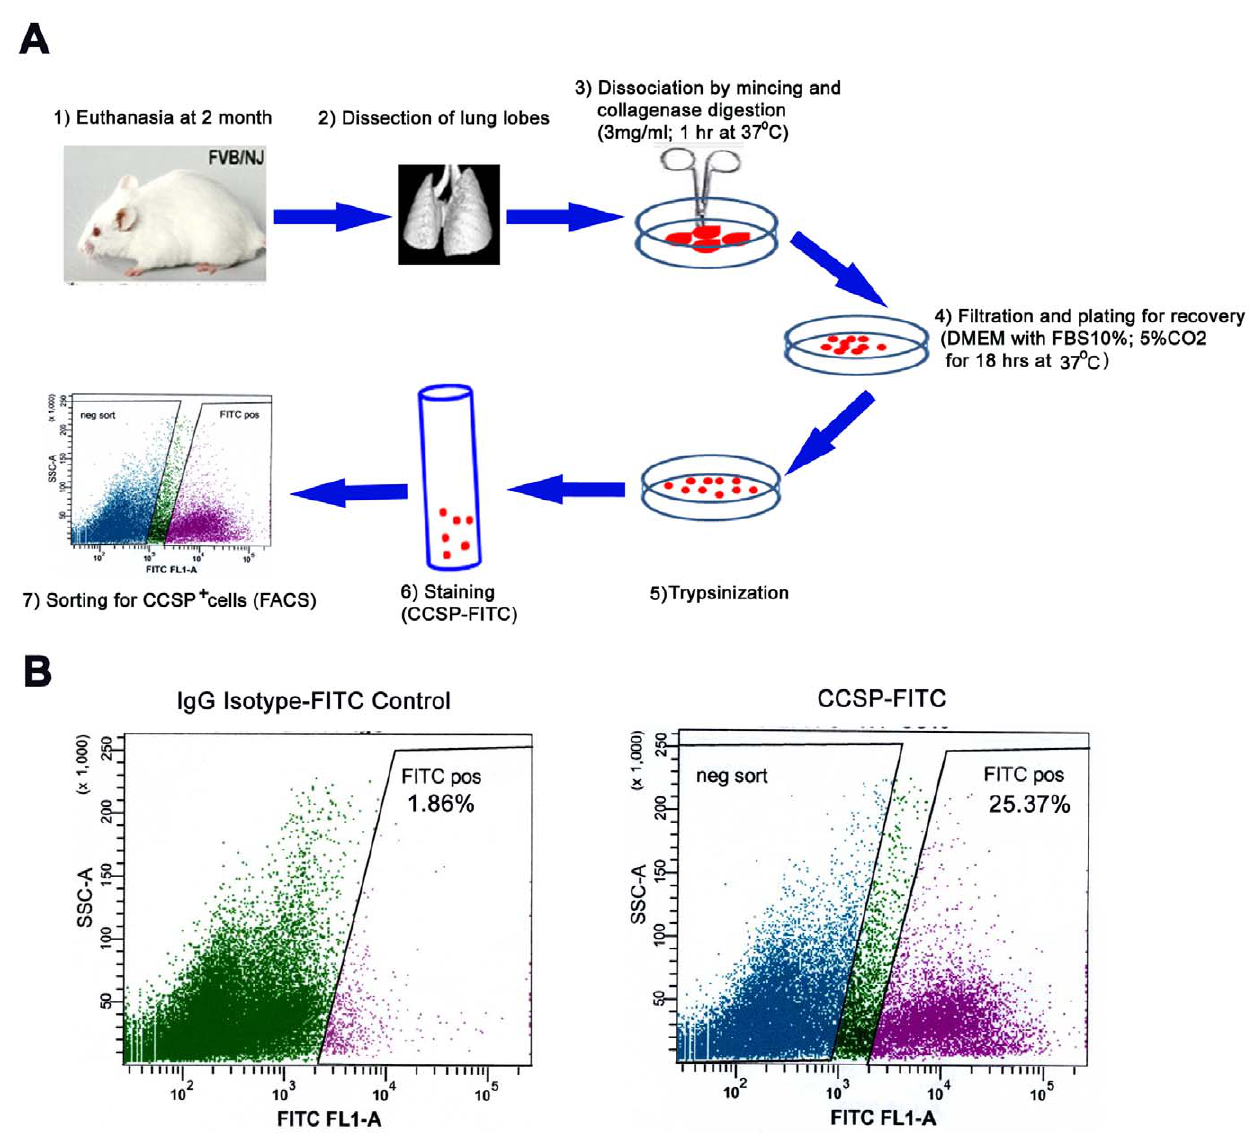
Figure 1. Schema for purification of primary CCSP positive cells from mouse lung. A) Two month old FVB mice were euthanized by CO 2, lungs removed and lobes collected. After washing in PBS, lobes were minced on ice and incubated in a small cell culture dish with 3 mg/ml collagenase in PBS (total 5 ml) in a shaking platform for 1 hour at 37 u C. The suspension was further disaggregated by trituration through a 19 gauge needle, with 5 ml of PBS, filtered through a 40 m m cell strainer and centrifuged at 1000 rpm for 5 min. The supernatant was discarded, cells resuspended in red blood cell lysis buffer for 4 min re-plated into 10 cm culture dishes for recovery overnight (18 hrs). Surviving cells were adhering to the dish. After trypsinization and neutralization by 10% FBS media, cells were resuspended in PBS with 3% FBS, and stained with rabbit anti-CCSP antibody and FITC conjugated anti-rabbit secondary antibody. CCSP + and CCSP 2 cells were sorted with FACS Vantage SE cell sorter. B) Rabbit IgG was used as an isotype -matched negative control; CCSP + population sorted with FACS Vantage SE cell sorter from dissociated lung tissue was 25.37%.